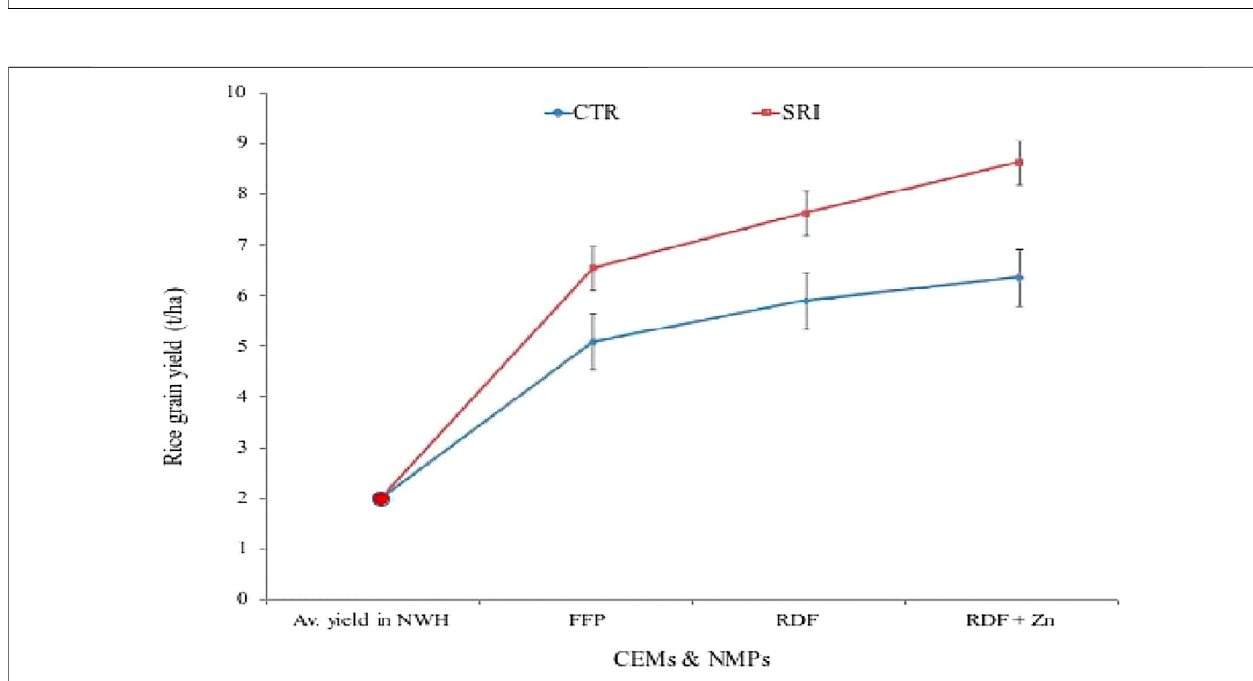
FIGURE9| In fl uenceofdifferentNMPsongrainyieldenhancementbothunderCTRandSRI(4yearsav.)overtheaverageyieldinthenorthwesternHimalayas.The vertical bars indicate the LSD at p = 0.05.